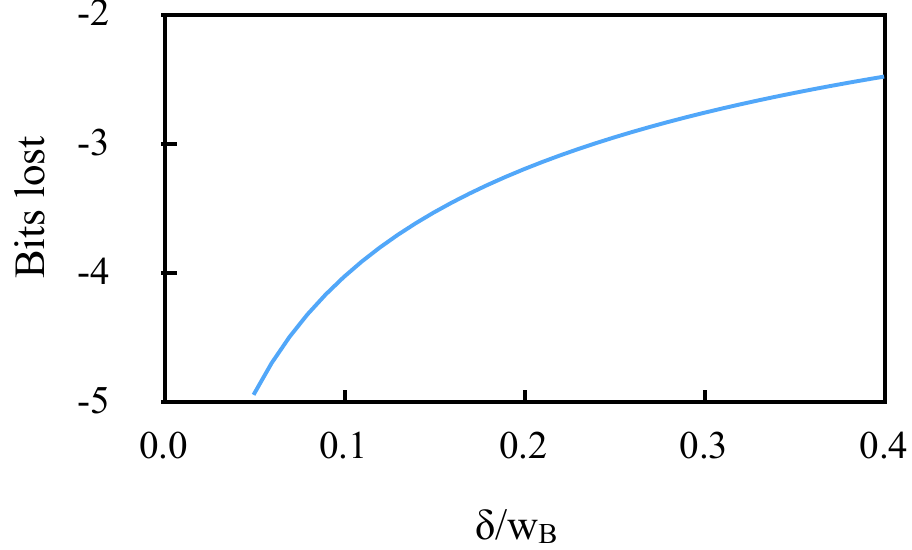
Figure 2. Resolution bits lost from B pd as a function of ( δ / w B )